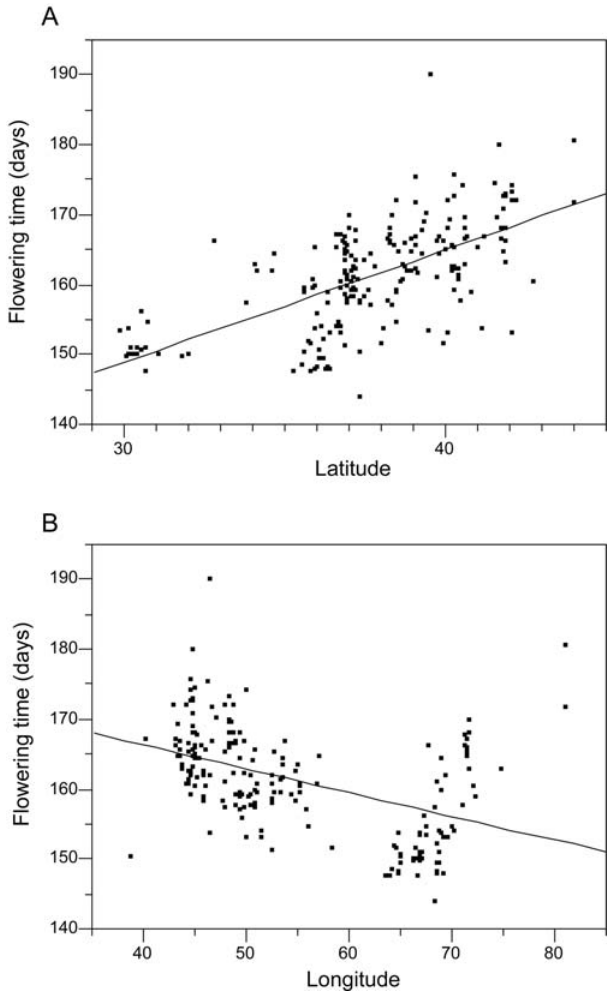
Figure 4. Geographic clines of flowering time. A) The relationship between latitude of origin and flowering time (regression coeffi- cient 6 SE=1.61 6 0.14, P , 0.0001). B) The relationship between longi- tude of origin and flowering time (regression coefficient 6 SE= 2 0.34 6 0.05, P , 0.0001).